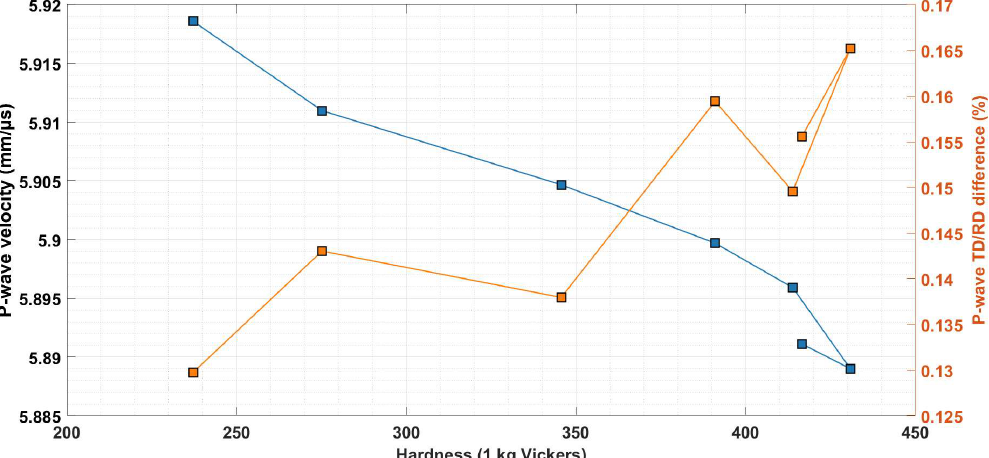
Figure 13. The blue square markers represent the longitudinal wave velocity in the normal direction for the tempered martensitic samples (left y-axis). The leftmost point is the 650 °C tempered martensitic sample, and the last point on the line represents the as-received sample, i.e., un-tempered. Orange squares and line show the anisotropic variation that originates from the (weak) texture.